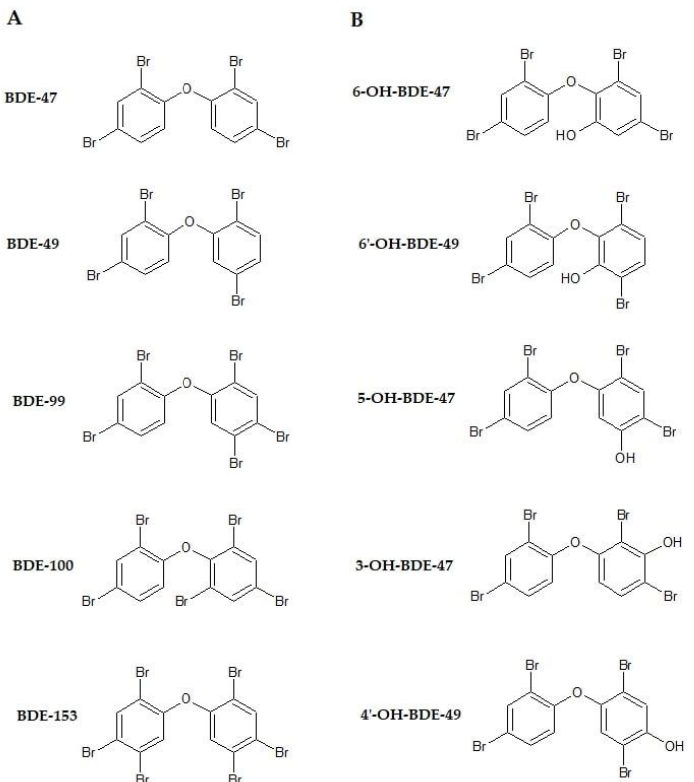
Figure 2. Molecular structure of ( A ) the PBDEs (BDE-47, BDE-49, BDE-99, BDE-100, BDE-153) and ( B ) the metabolites of BDE-47 (6-OH-BDE- 47, 6′ -OH-BDE-49, 5-OH-BDE-47, 3-OH-BDE- 47, and 4′ -OH-BDE-49) (modified from [141]).